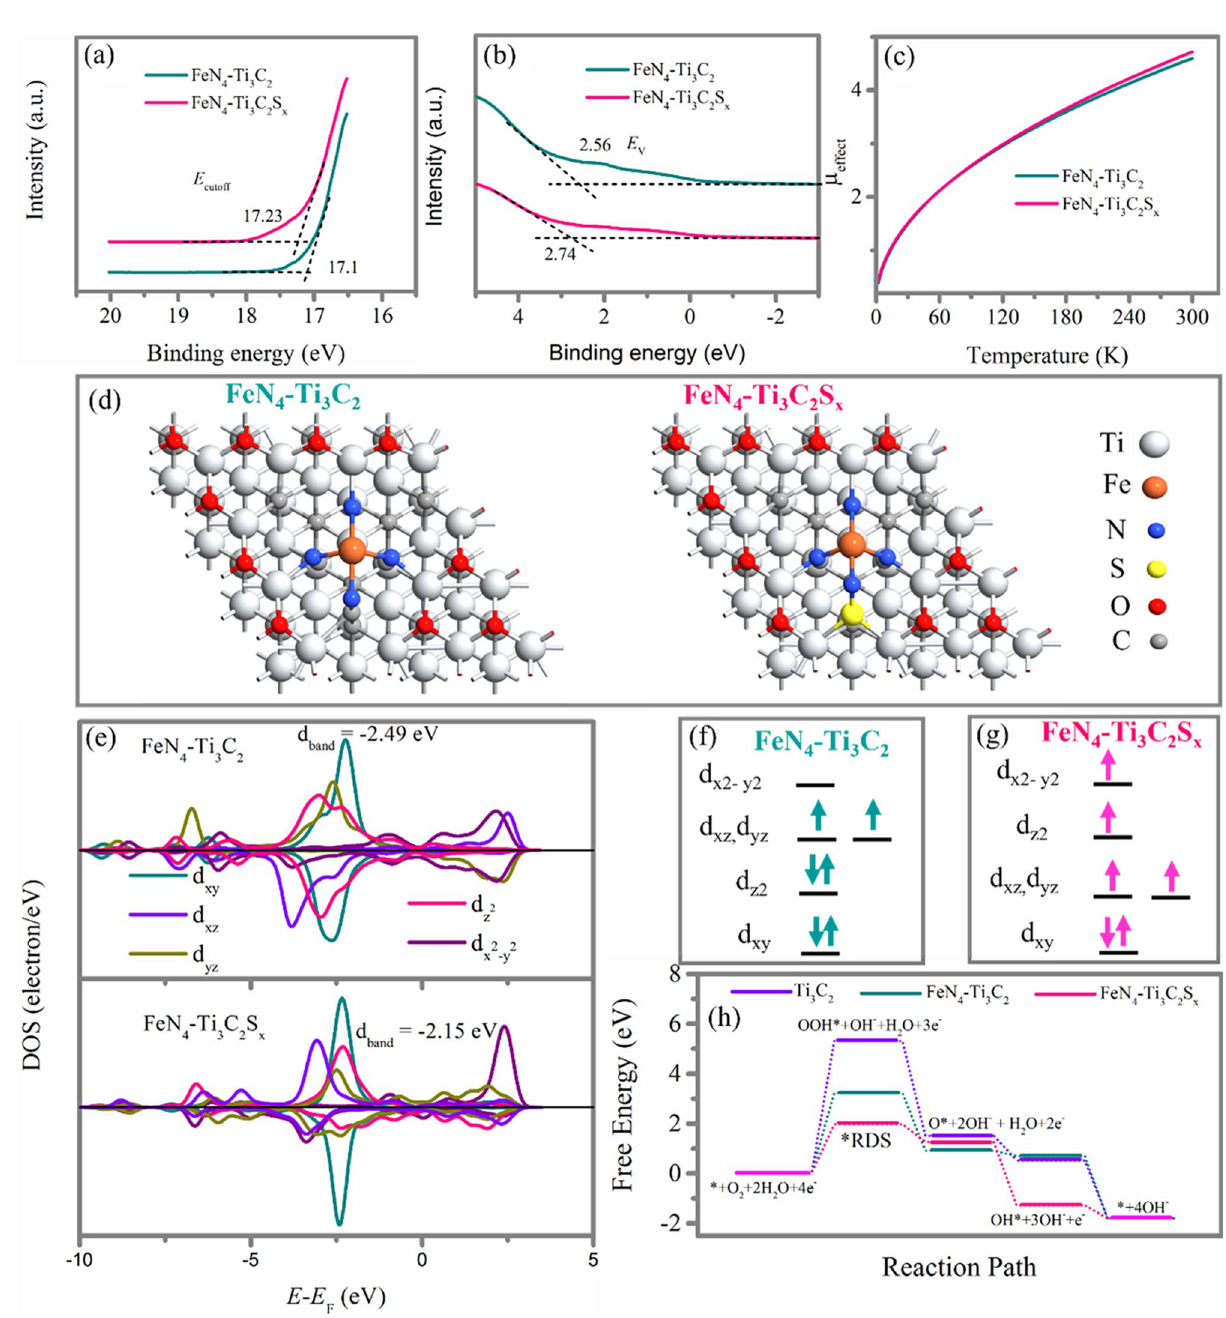
Fig. 5 UPS spectra of samples FeN 4 –Ti 3 C 2 , and FeN 4 –Ti 3 C 2 S x : a in the normalized secondary electron cutoff energy E cutoff regions, and b the valence band maximum E V regions. c The effective magnetic moment µ effect for samples FeN 4 –Ti 3 C 2 , and FeN 4 –Ti 3 C 2 S x , obtained from M–T measurements. d Top view of computational optimized atomic structures of FeN 4 –Ti 3 C 2 (left) and FeN 4 –Ti 3 C 2 S x (right). e PDOS of the Fe center in samples FeN 4 –Ti 3 C 2 (above), and FeN 4 –Ti 3 C 2 S x (below). To better present the location of energy states around the Fermi level, Fermi level is always defined to be 0 eV. Schematic representation of the electronic spin state of partial Fe(II) on f FeN 4 –Ti 3 C 2 , and g FeN 4 –Ti 3 C 2 S x . h Free energy diagram for the optimized atomic structures of Ti 3 C 2 , FeN 4 –Ti 3 C 2 , and FeN 4 –Ti 3 C 2 S x during ORR under alkaline